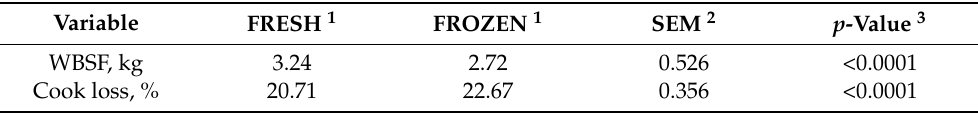
Table 6. Least squares means for effect of storage conditions on tenderness of striploin steaks from grain- and grass-finished